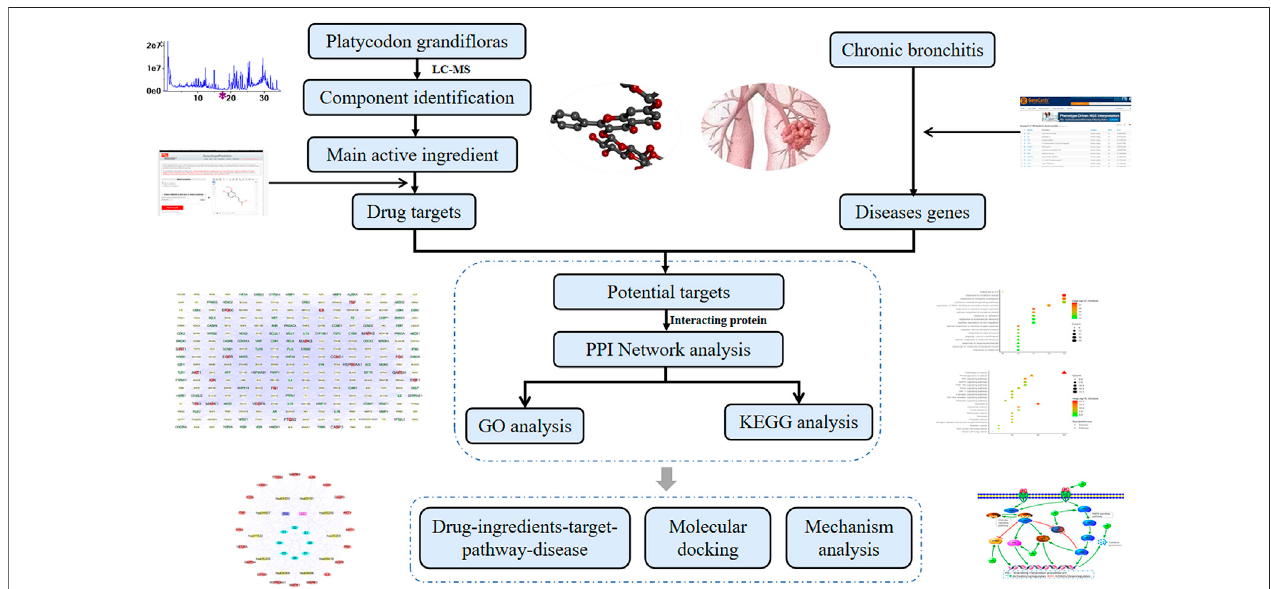
FIGURE 1 | A comprehensive strategy diagram the chemical ingredients analysis, targets prediction, and network calculation for investigation the mechanism of action of Platycodon grandi fl orum on lung cancer.